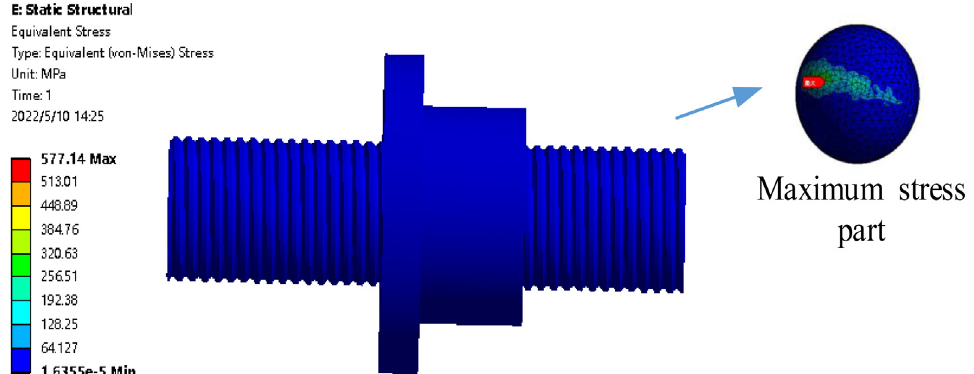
Fig. 10. Cloud diagram of stress distribution of ball screw.